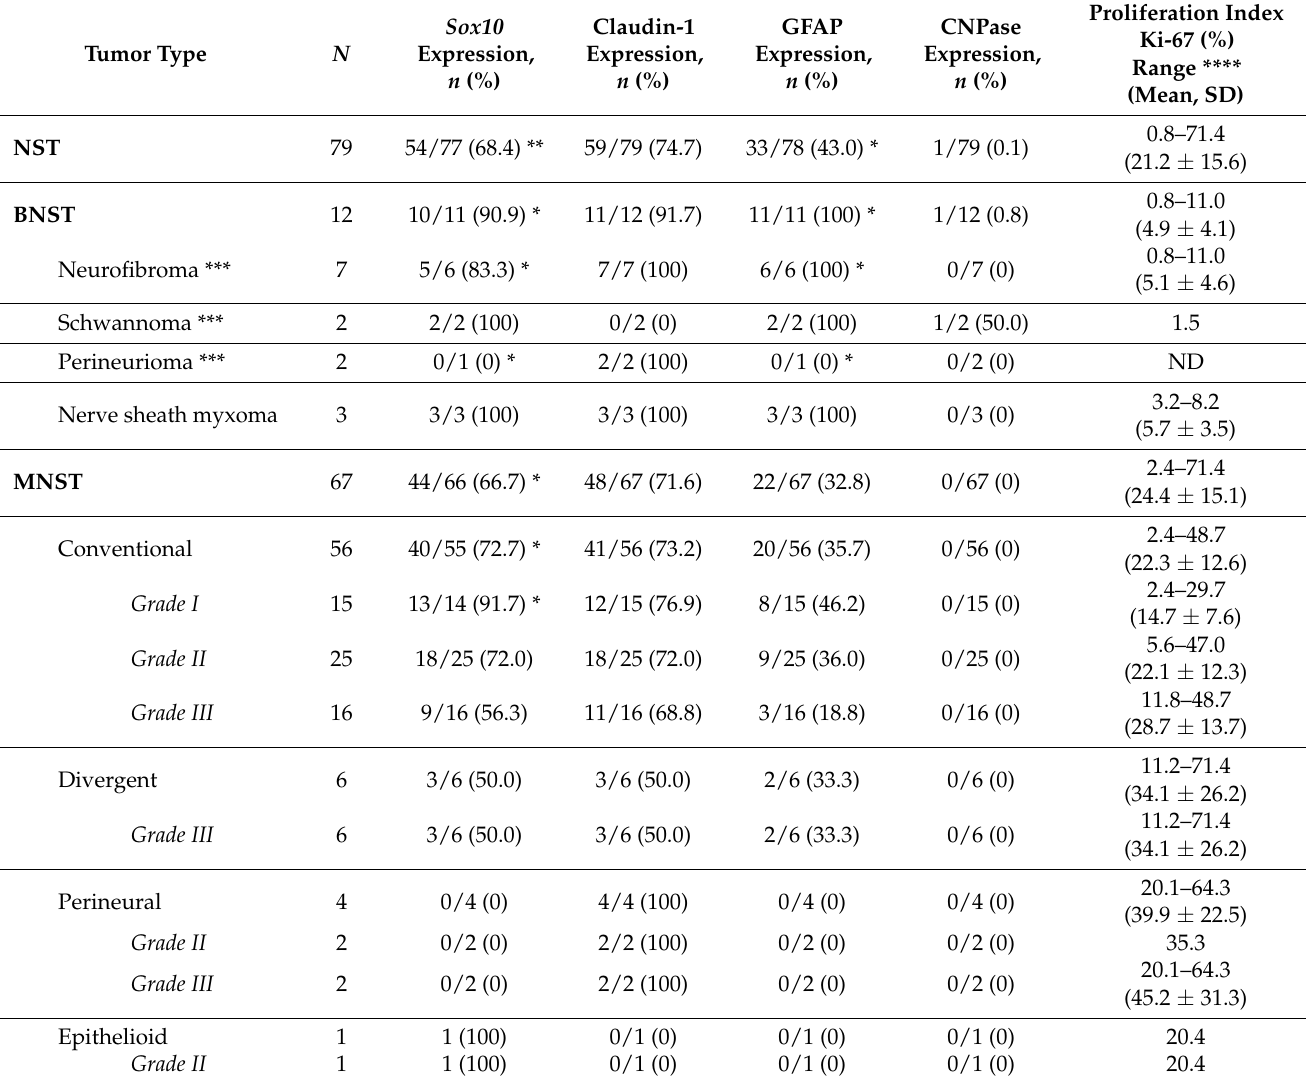
Table 6. Results of immunohistochemical analysis for Sox10 , Claudin-1, GFAP, CNPase, and prolifer- ation index Ki-67 in each subtype and variant of